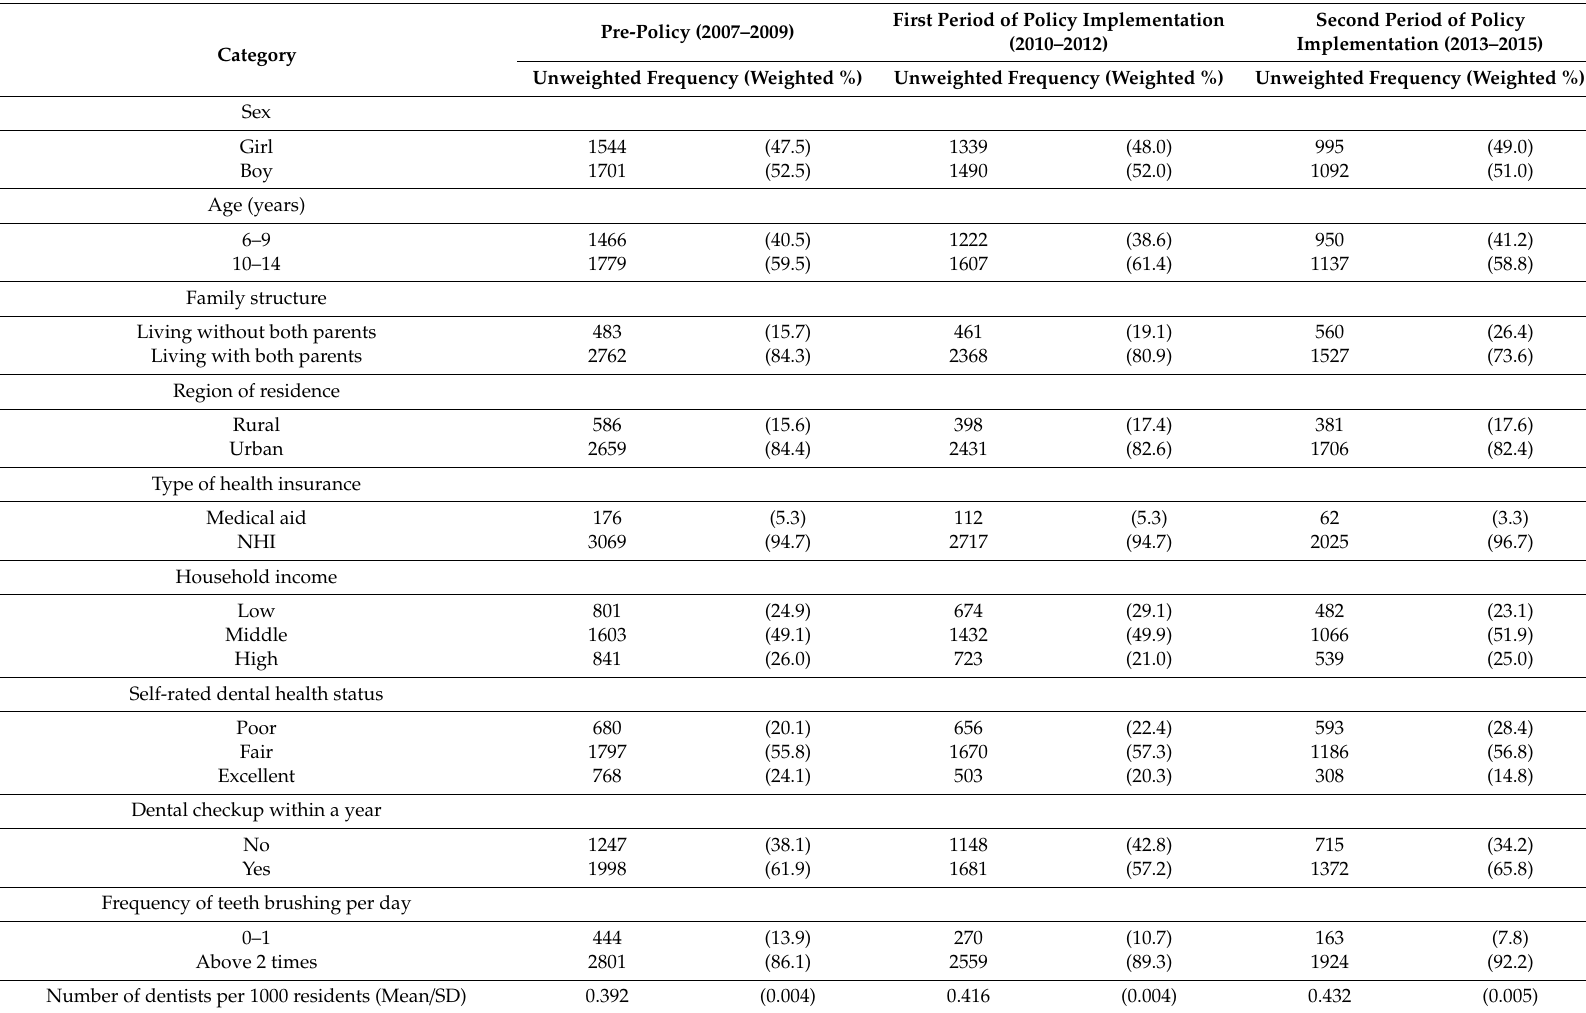
Table 1. Changes in the covariates over the three time